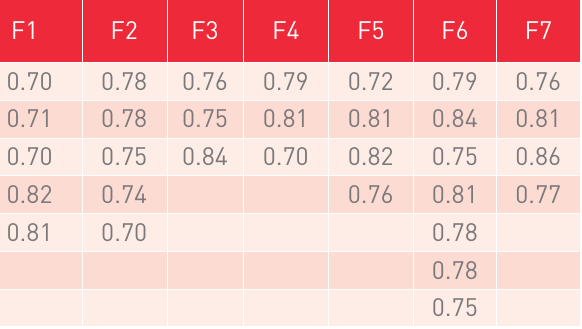
Loadings of the SC measurement model